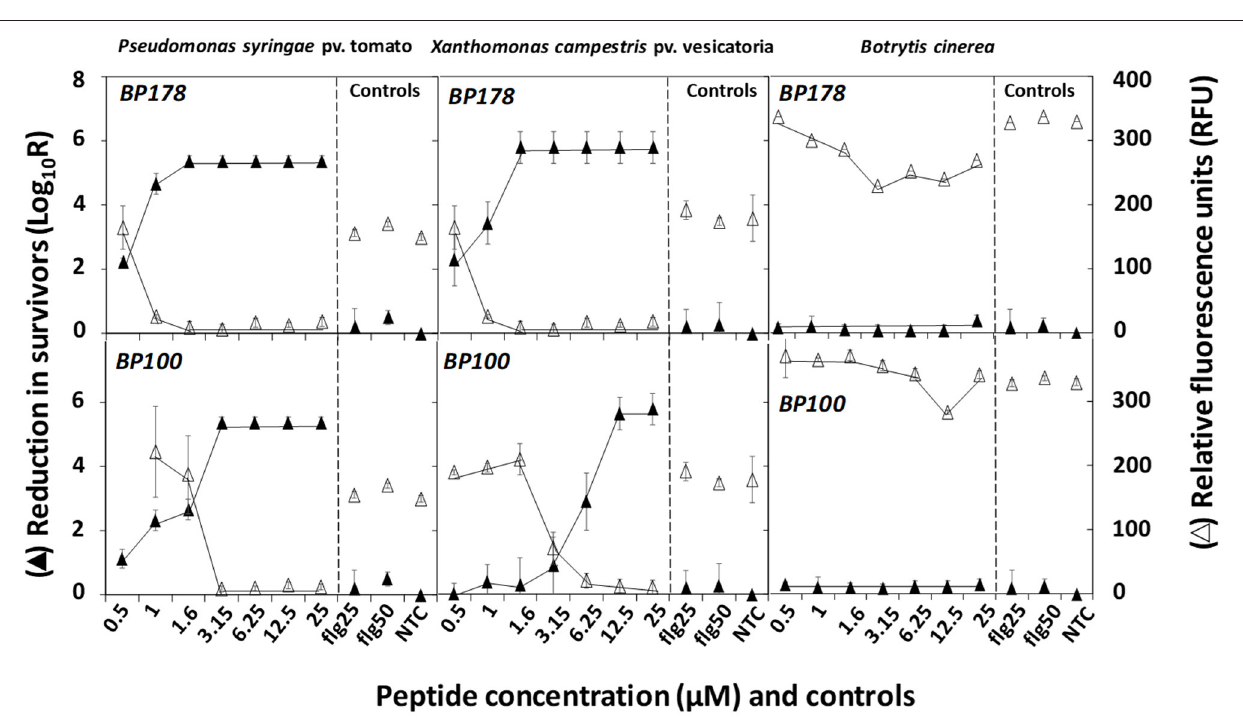
values ranging between 25 and 100 µ M. Peptide flg15 was neither antibacterial nor antifungal at the maximum dose tested (100 µ